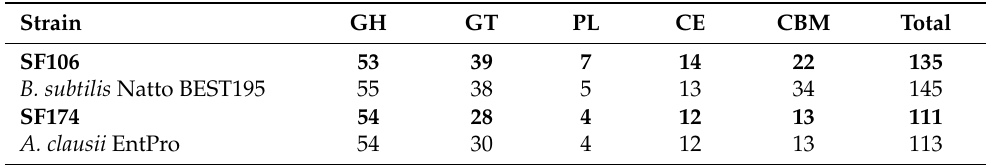
Table 3. Number of putative genes for families of the esterases and glycoside hydrolases CAZymes categories in SF106 and